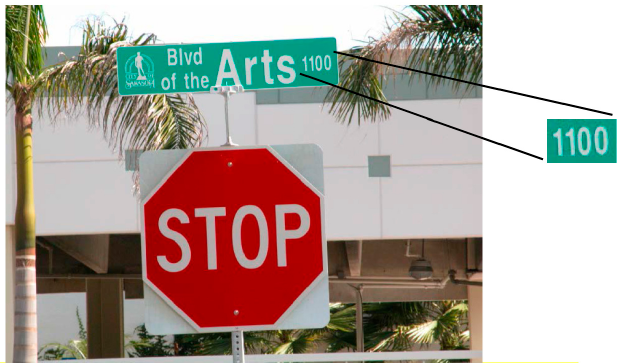
Figure A1. Watermarked color image, publicly available from the McGill Calibrated Color Image Database [30] (http://tabby.vision.mcgill.ca/html/welcome.html), PSNR = 67.02 dB (with zoom on detail). J. Imaging 2017 , 3 , 34